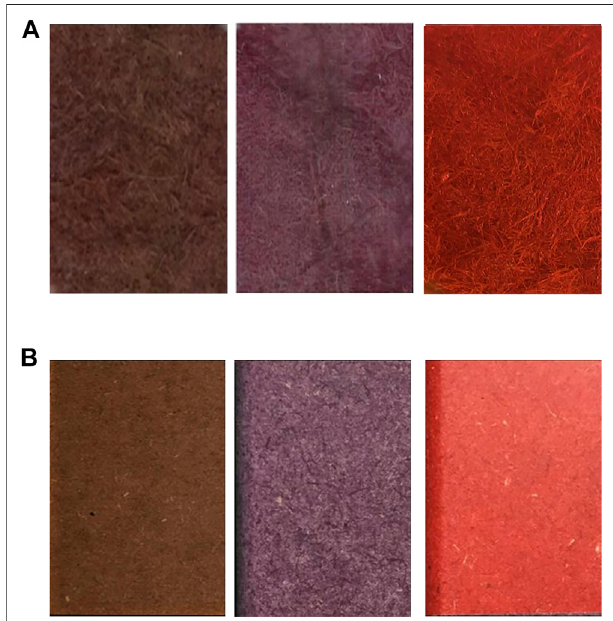
FIGURE 6 | Comparison of dried pressed wood fi ber panels that were previously dyed toward laccase catalysis (A) with the commercially dyed MDF already present on the market (B)